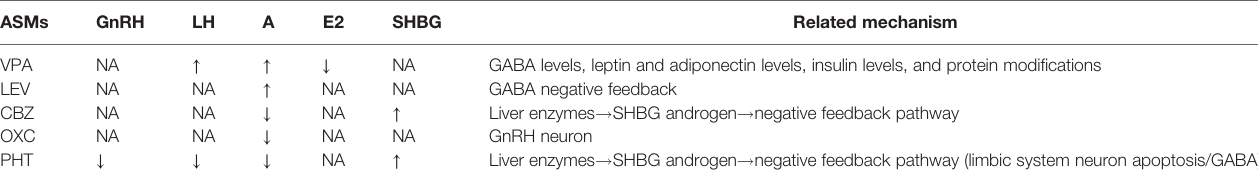
TABLE 1 | The in fl uence of anti-seizure medications (ASMs) on the hypothalamic – pituitary – ovarian (HPO) axis (5, 14, 16, 72, 134, 140, 142, 143).